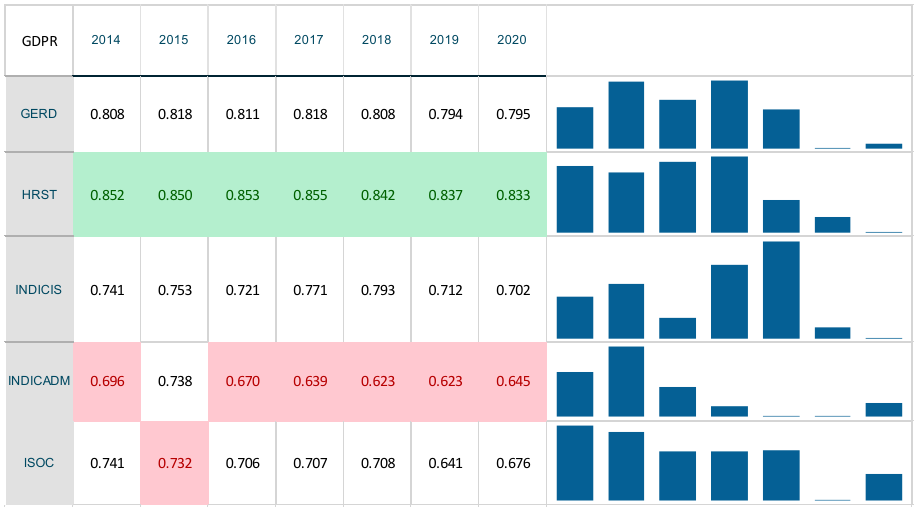
Figure 10. Pearson correlation overview with seasonal influence and impact on sustainable regional development